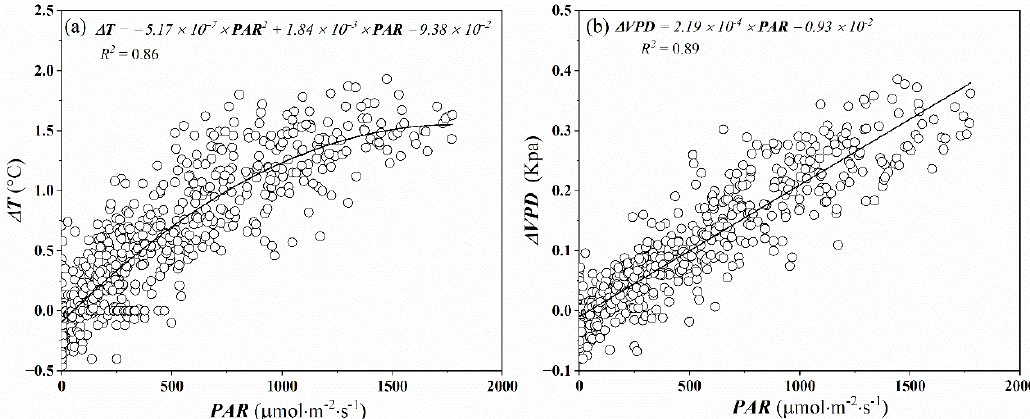
Figure 3. Variations in air temperature difference ( Δ T ) ( a ) and vapor pressure deficit difference ( Δ VPD ) ( b ) between inside and outside of the chamber were measured at the end of the 6 min chamber closing period with incident light ( PAR ). Non-linear and linear regressions (black lines) are also shown.